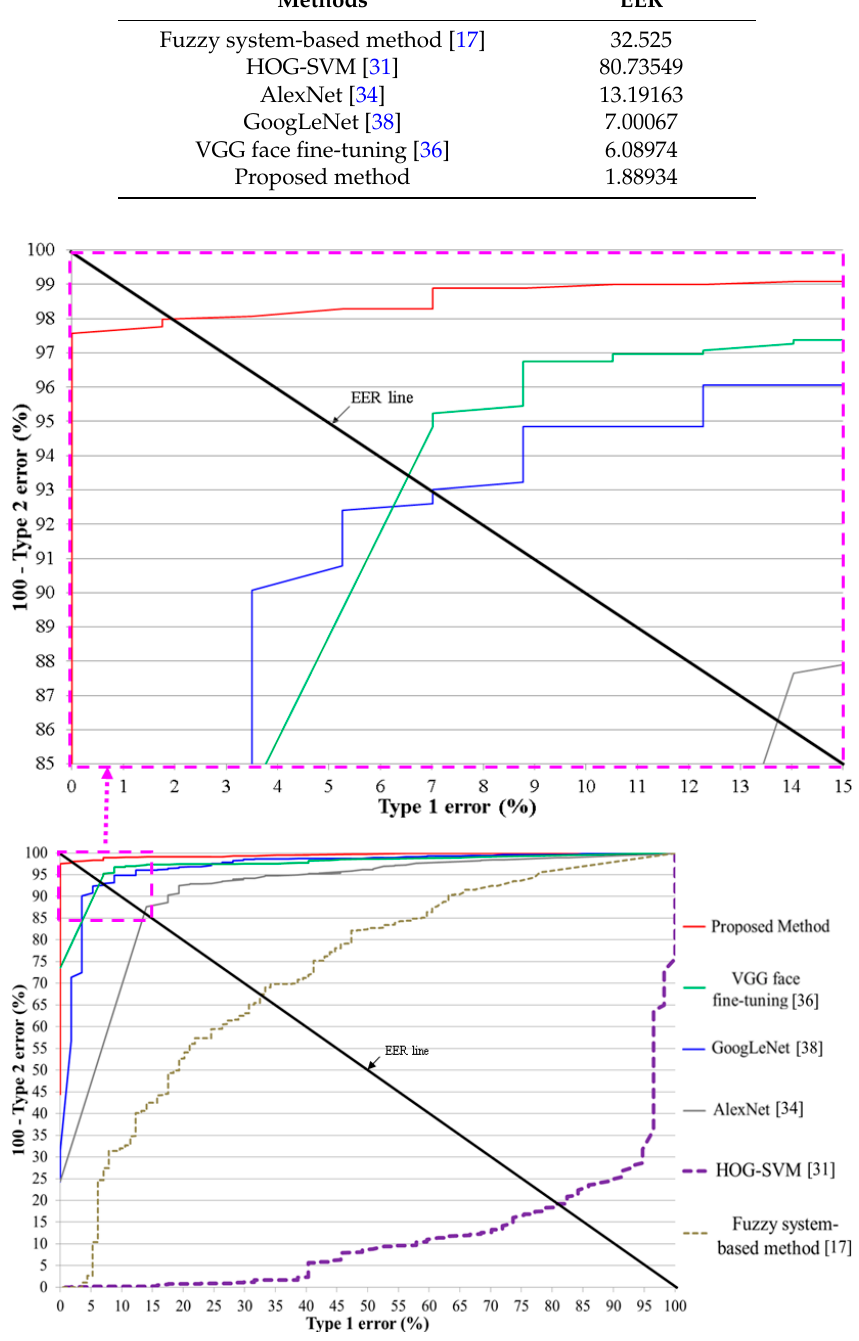
Figure 11. ROC curves with open database of near-infrared (NIR) eye images.